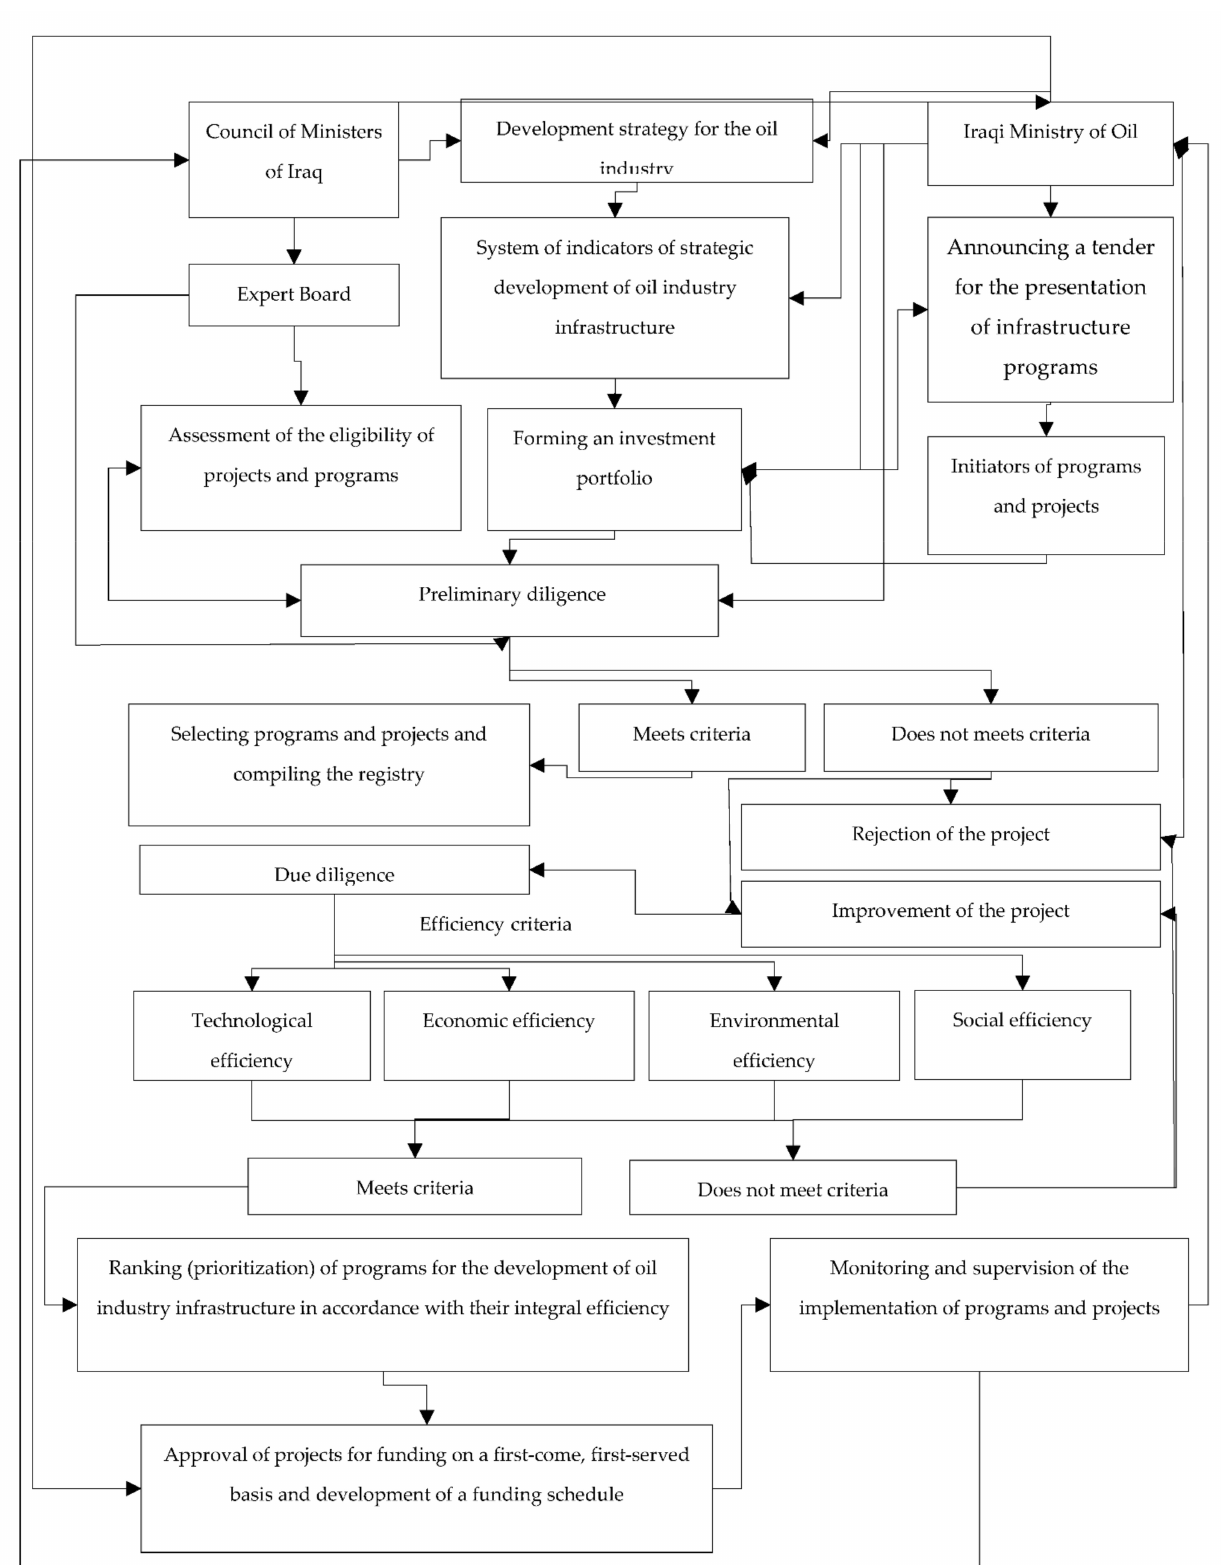
Figure 4. Diagram of the implementation of the management process of the Iraqi oil industry infrastructure development on the basis of the program implementation of the model system of strategic development